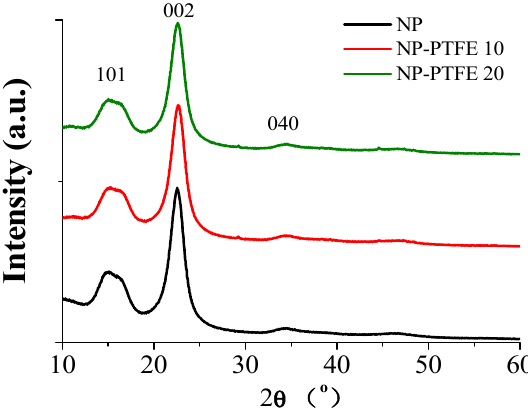
Figure 9. X-ray diffraction (XRD) of the the new pressboard, pressboard surface coated PTFE film for 10 min and 20 min.